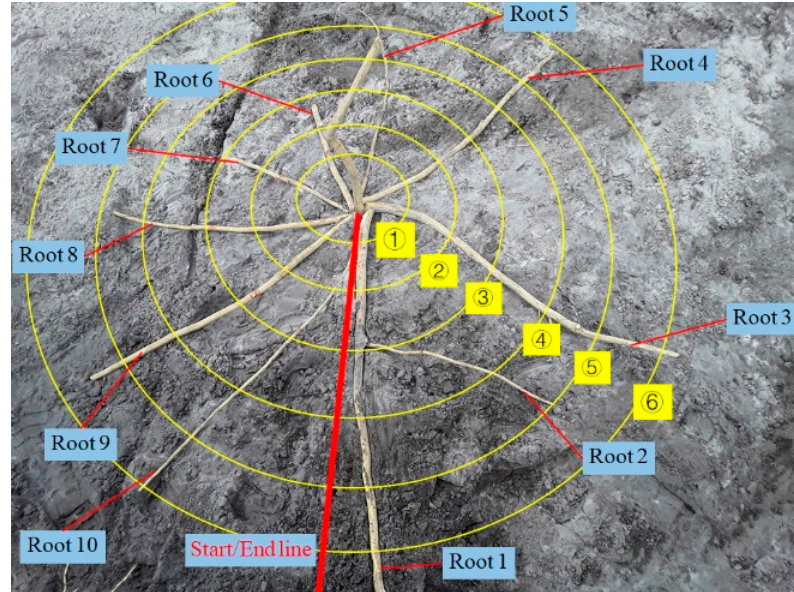
Figure 5. Simulated tree root experiment. This figure presents the root distribution, root location, root number, and the “scan” lines